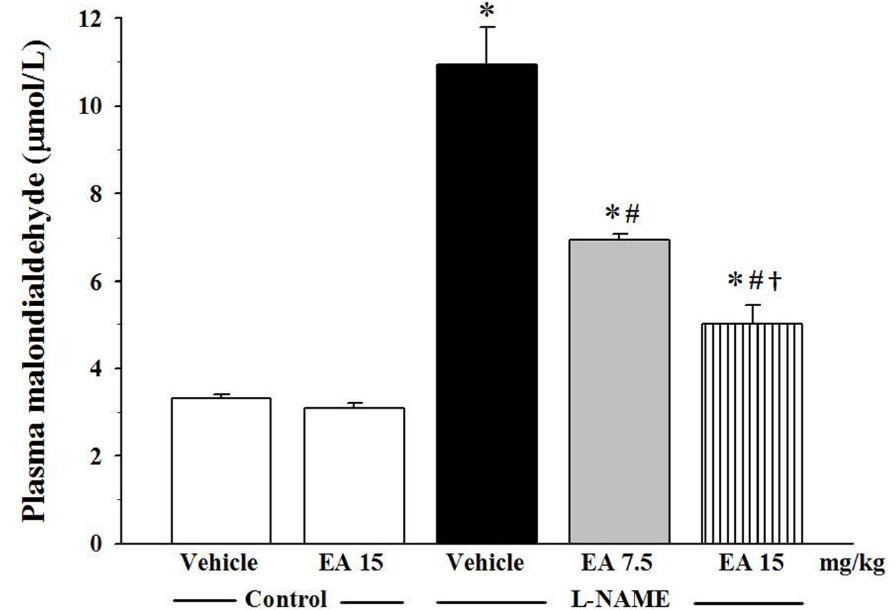
Figure 3. Effect of ellagic acid on plasma malondialdehyde levels. Values are expressed as mean ± SEM, n = 7. * p < 0.05 when compared to control group, # p < 0.05 when compared to L-NAME group and † p < 0.05 when compared to L-NAME+EA 7.5 mg/kg group.